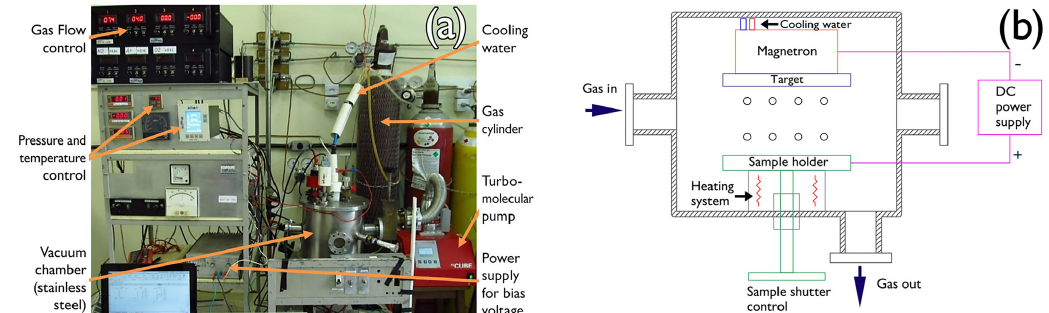
Figure 1. (a) Photography and (b) scheme of the experimental set-up for film